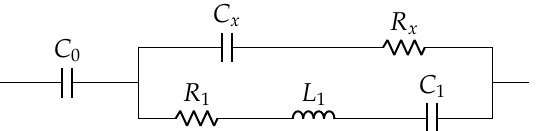
Figure 7. Banerjee model: unloaded